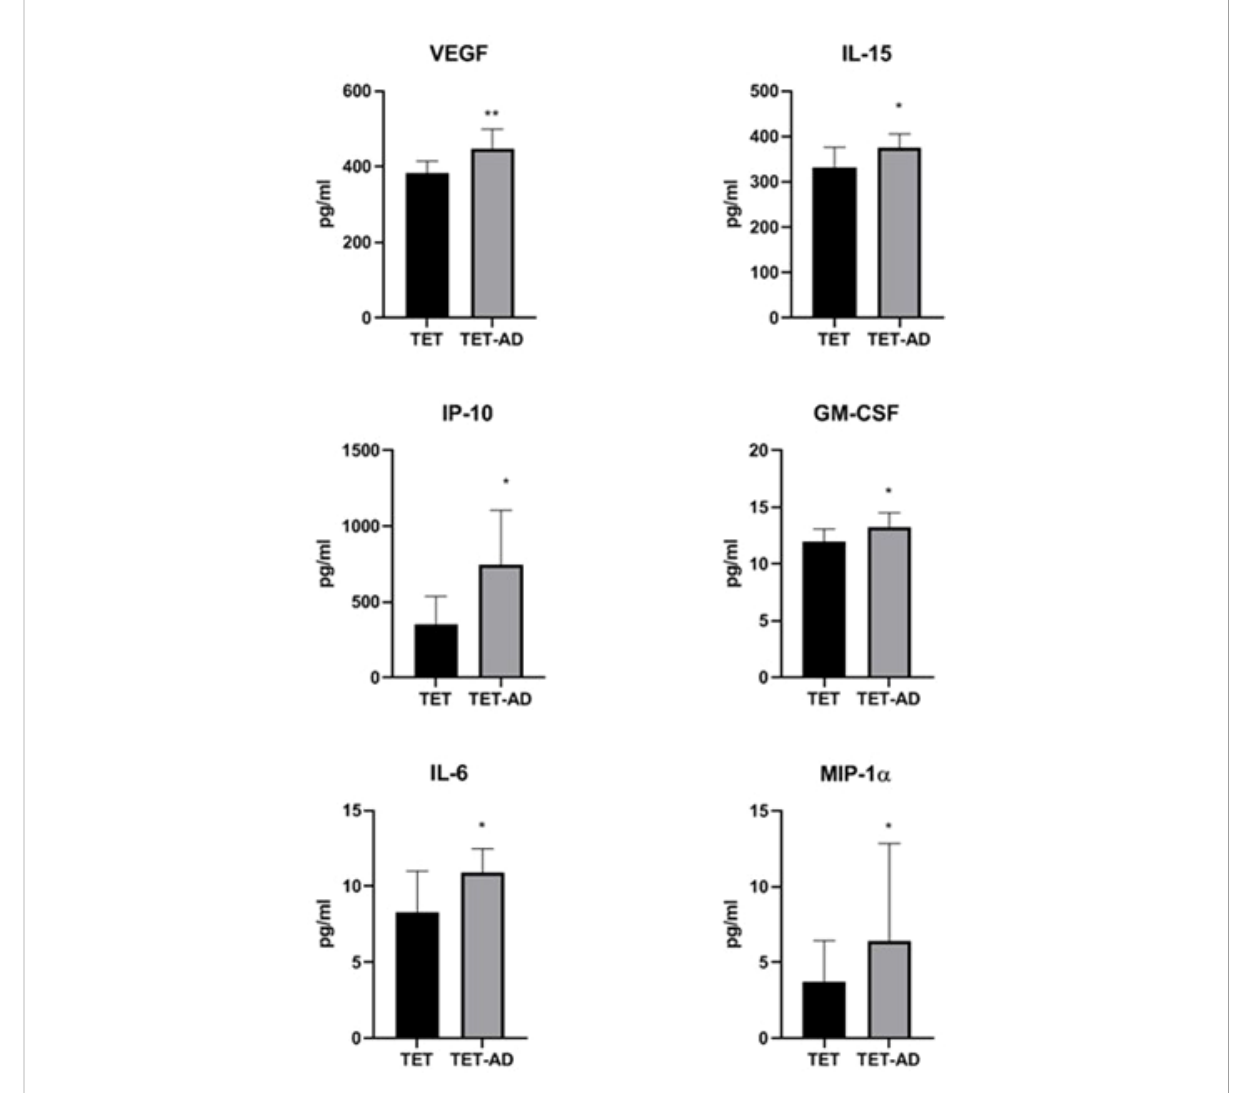
FIGURE 3 Serum concentration of cytokines, chemokines and growth factors. Histograms indicate cytokine concentrations (pg/ml) in TET (N = 8) and TET-AD (N = 9) patients. The histogram of IL-6 includes TET (N = 7) and TET-AD (N = 9) patients. The histogram of MIP-1 a includes TET (N = 7) and TET-AD (N = 8) patients. Results are indicated as mean ± SD. A two-tailed t-test for independent samples test was performed to analyze data (*p < 0.05; **p <